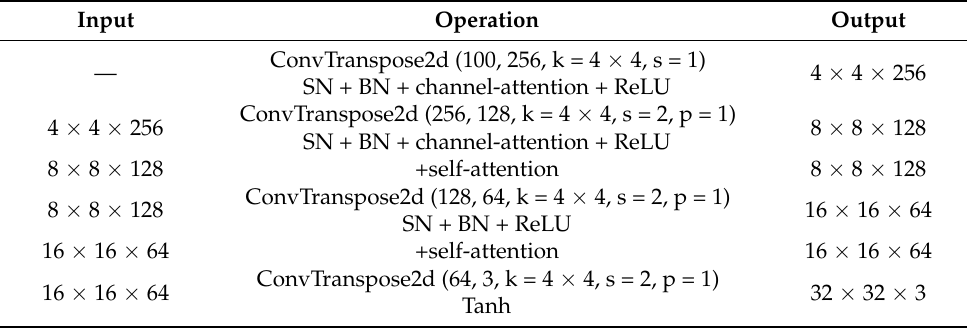
Table 3. The network structure of the generator in CIFAR-10.